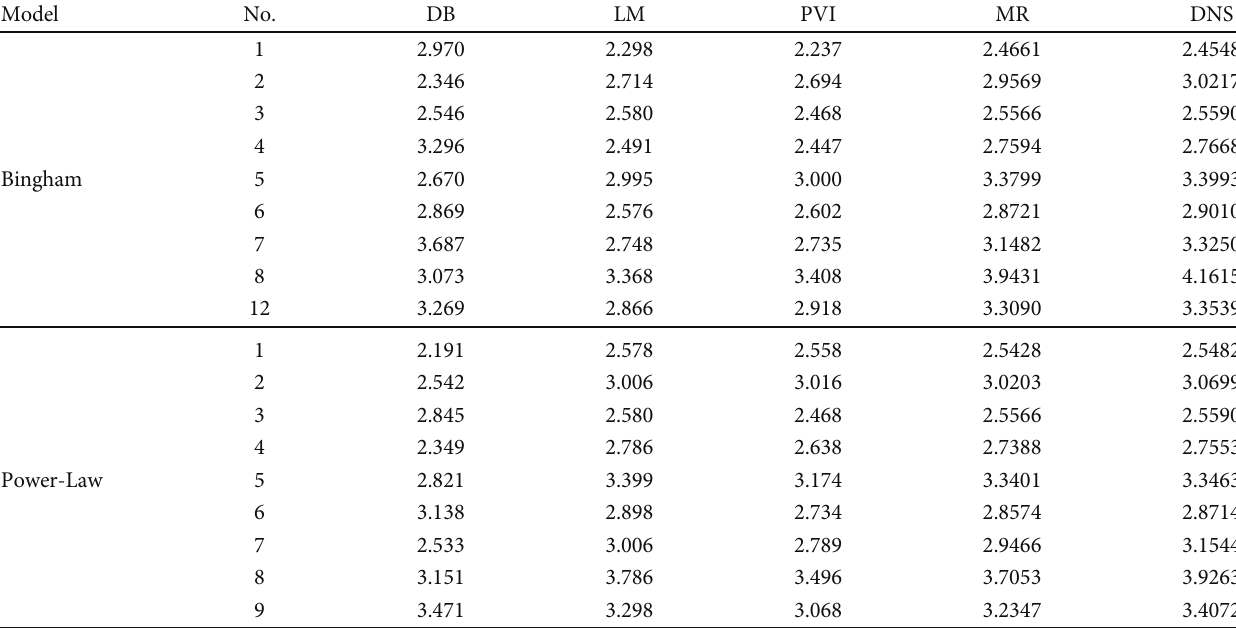
Table 7: Comparison of ECD results from fi ve methods for annulus with varied radial sizes.